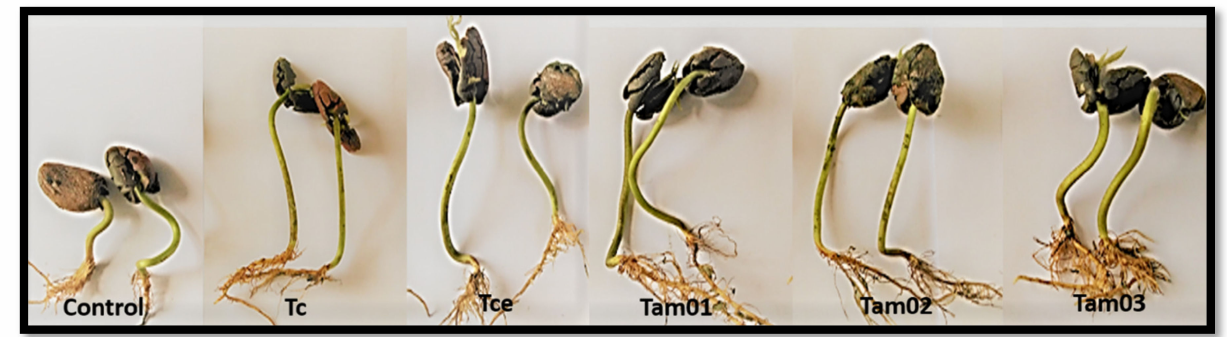
Figure 1. Radicle and hypocotyl lengths of cocoa seedlings resulting from seeds treated or not with different Trichoderma spp.